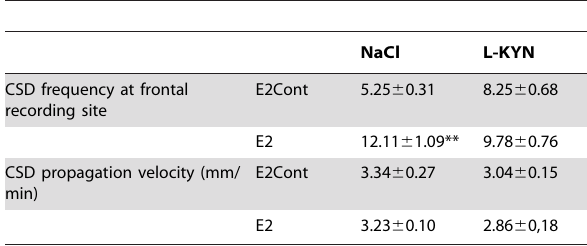
Table 1. CSD frequency at the frontal recording site and CSD propagation velocity in ovariectomized rats treated or not with